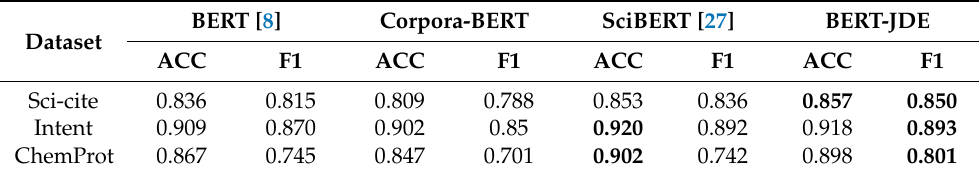
Table 2. Text Classification Experimental Results.